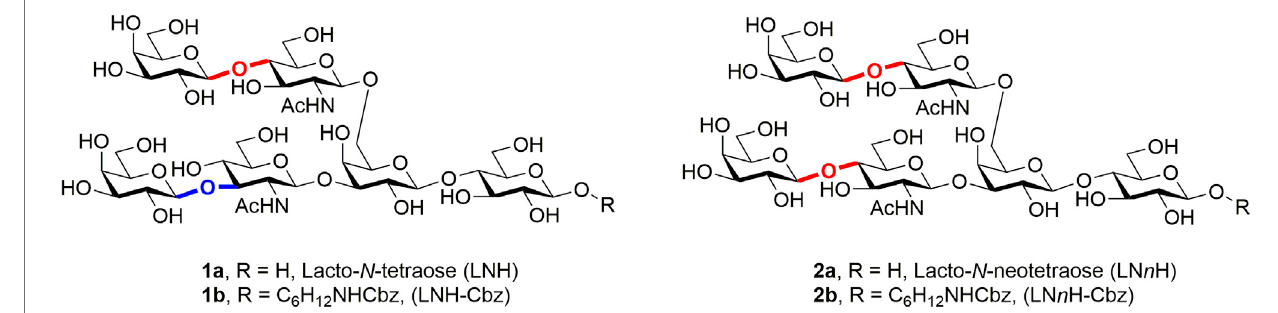
FIGURE 1 | Structure of LNH and LN n H.